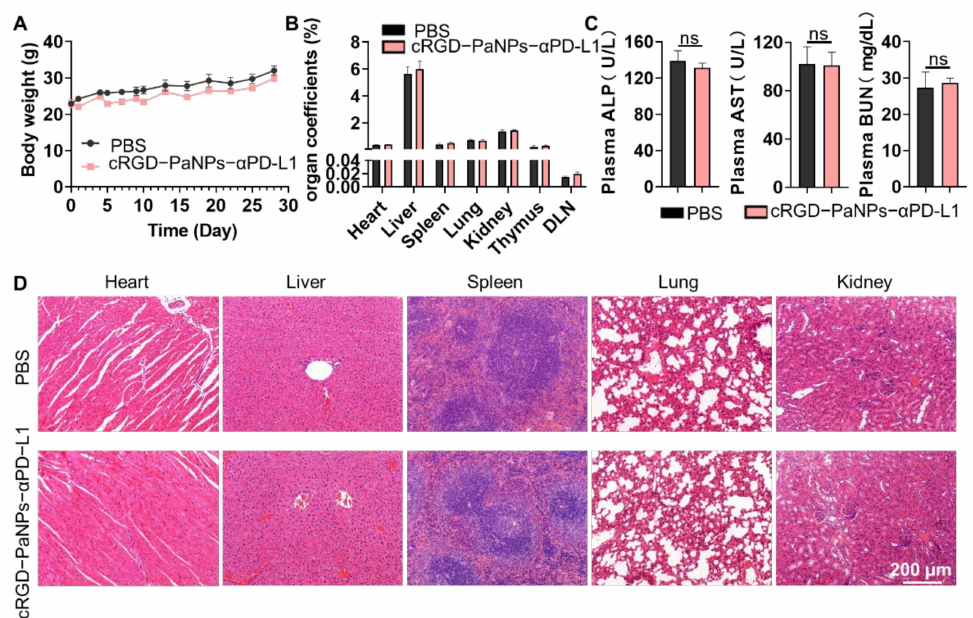
Figure 9. The toxicity evaluation of the cRGD–PaNPs– α PD–L1. ( A ) Body weight changes in the BALB/c mice after i.v. injection with cRGD–PaNPs (5 mg/kg of Pa and 100 µ g of α PD–L1). ( B ) Organ coefficients. ( C ) ALP, AST and BUN levels in blood. ( D ) H&E staining of the major organs. Data are presented as mean ± SD ( n = 3). ns, no significance between the two compared